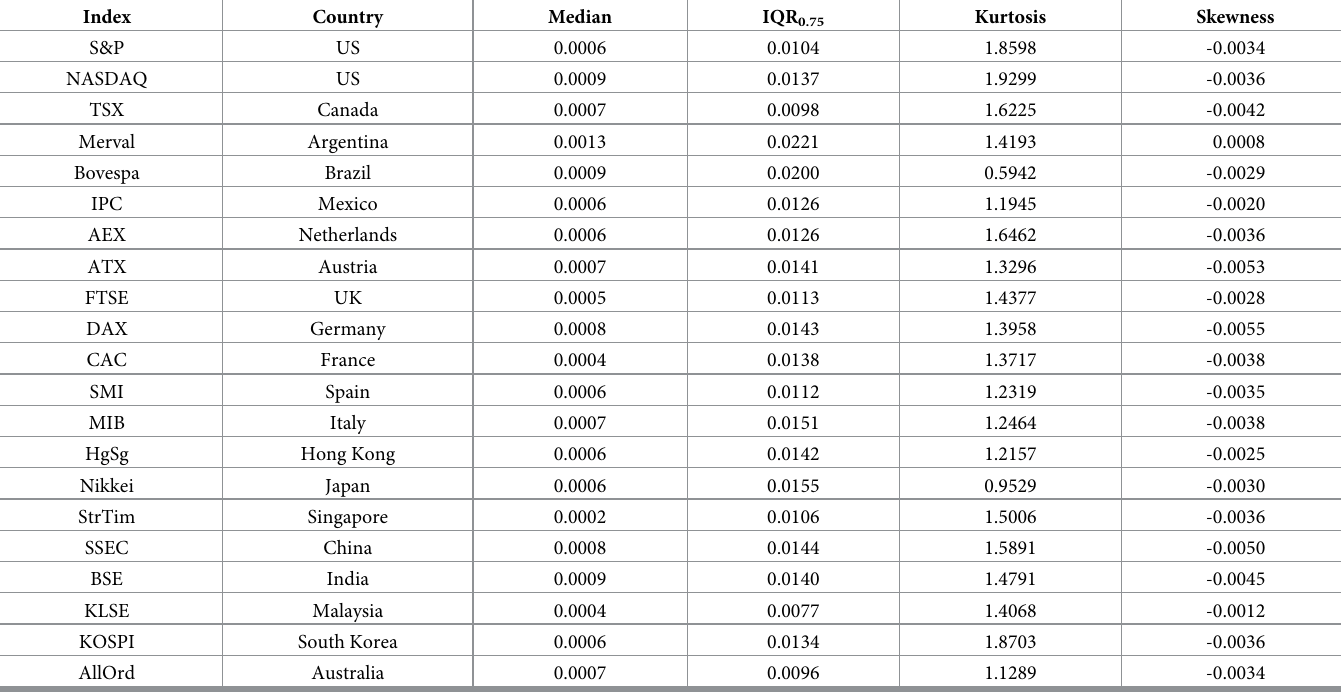
Table 2. Descriptive